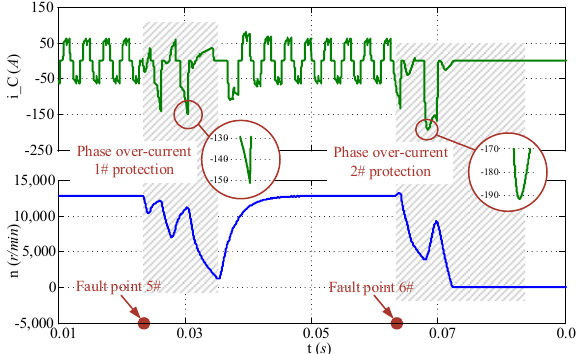
Figure 16. Waveforms of phase-current and motor speed during phase over-current fault protection process.